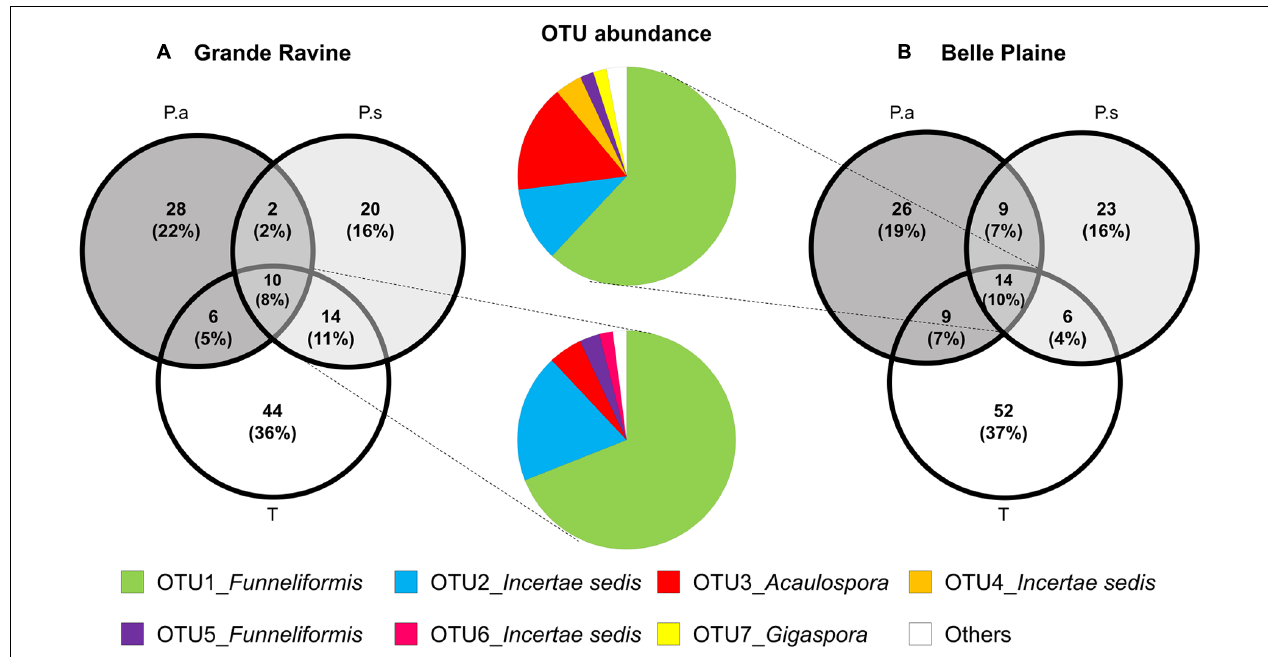
FIGURE 2 | Distribution of AM fungal OTUs shared among taro (T), Pterocarpus adult trees (P.a) and seedlings (P.s) in (A) Grande Ravine and (B) Belle Plaine forest sites. All sequences were clustered in OTUs (97% similarity). Data were rarefied to 440 sequences per sample. Venn diagrams represent the percentage of AM fungal OTUs specific to a given plant or overlapping among plants. Color pie charts represents the abundance of OTUs shared among the three plants for both forest sites. The category “Others” combines OTUs representing less than 1% (8 OTUs for BP and 5 for